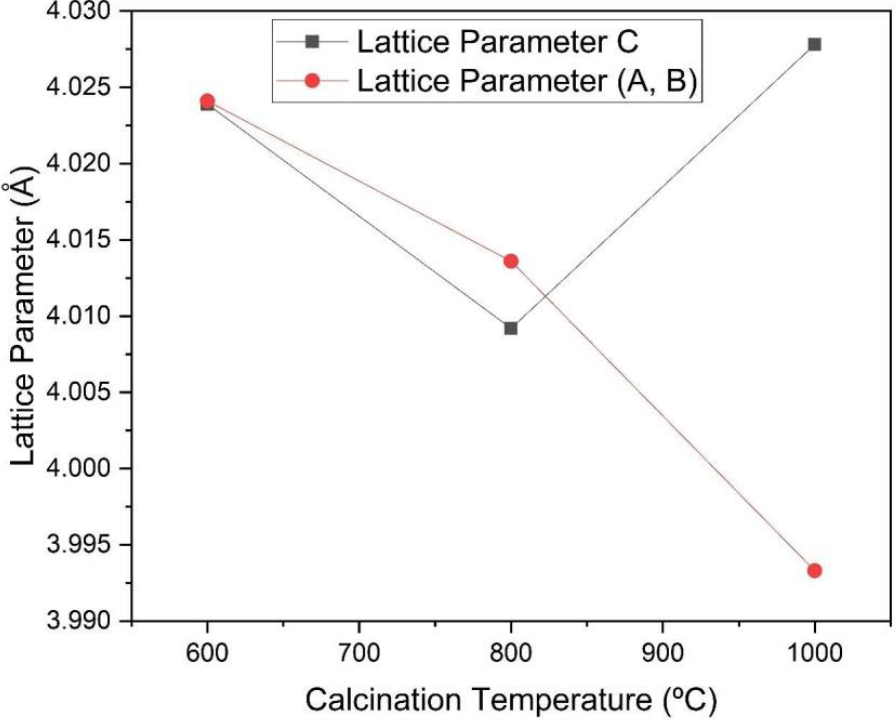
Figure 6. Network parameters as a function of the calcination temperature of the powders obtained by the sol-gel method and heat-treated at different temperatures (600 °C, 800 °C and 1000 °C).